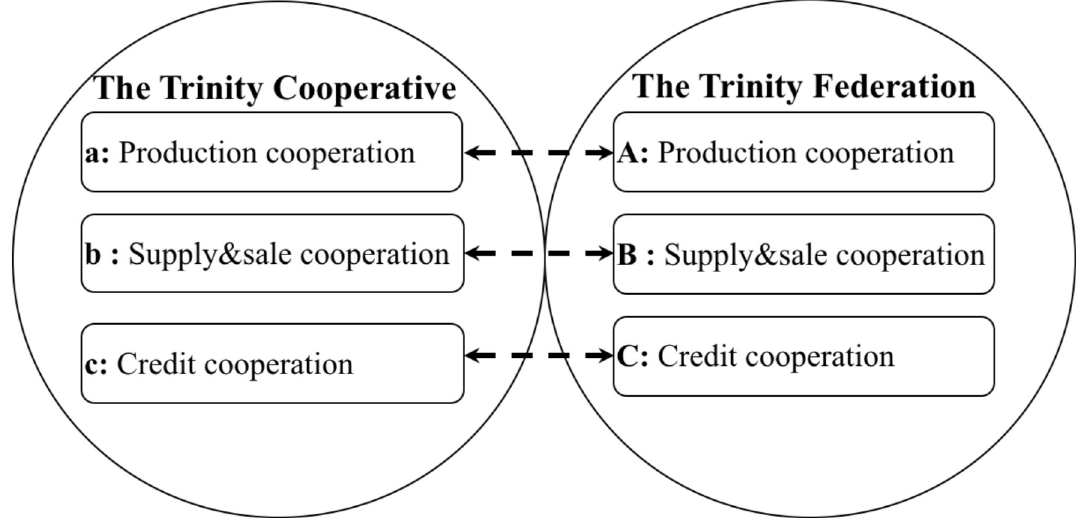
Fig 4. The cooperation patterns of trinity co-operatives and